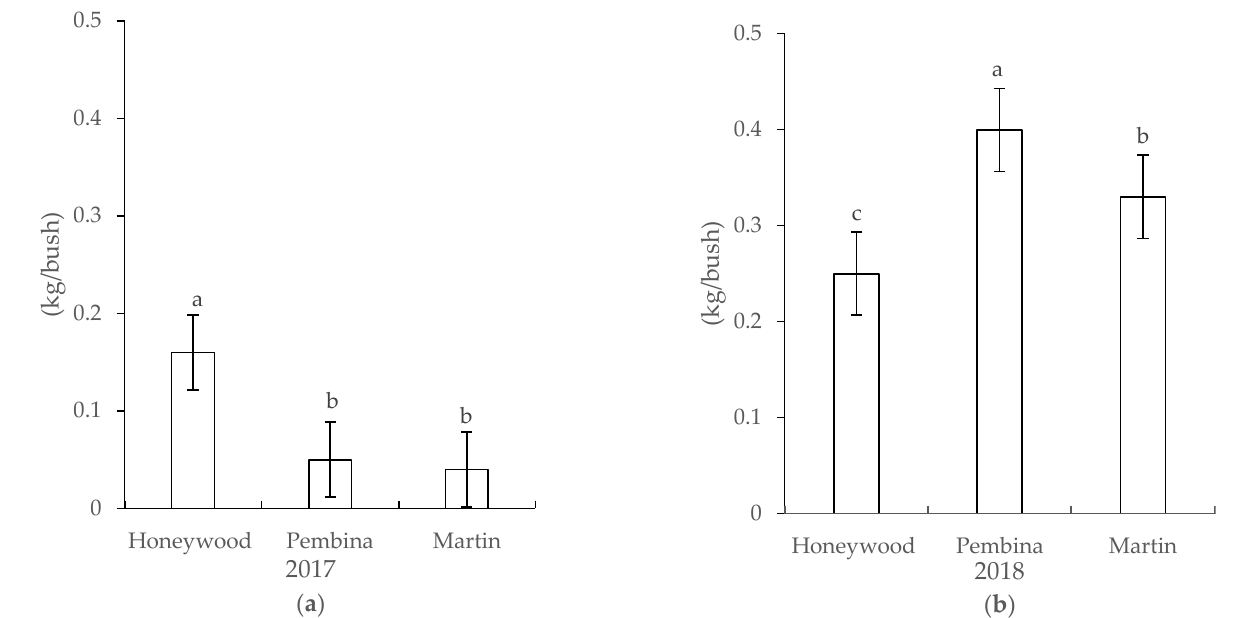
Figure 2. Yield of the studied cultivars in ( a ) 2017 and ( b ) 2018. Values with different letters are significantly different within a year.